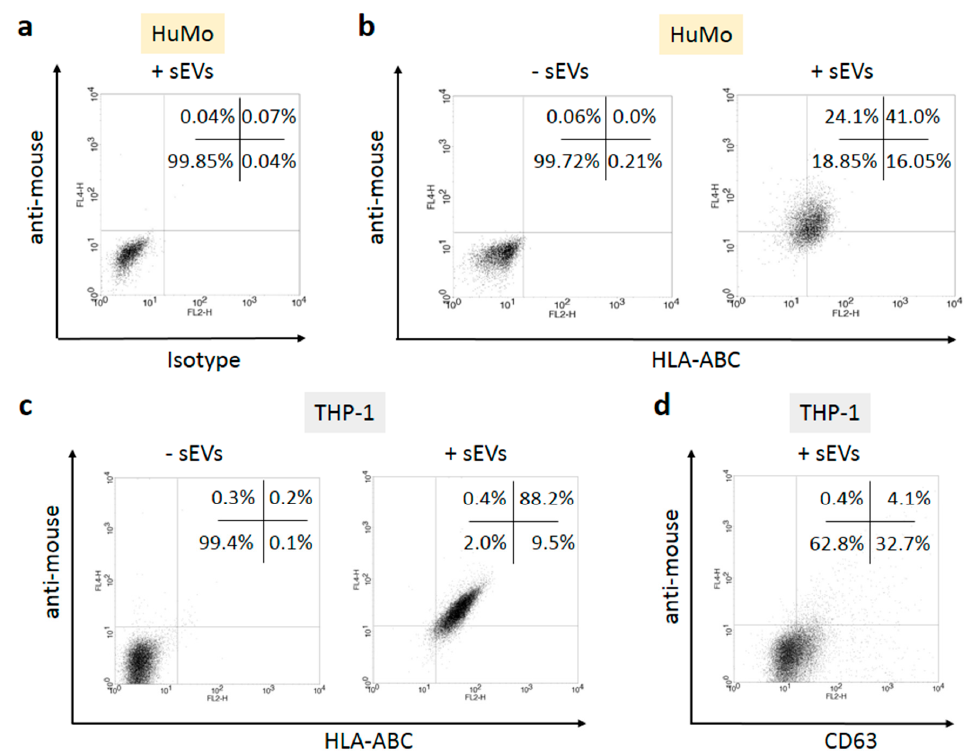
Figure 2. Melanoma cell-derived sEVs transfer MHC class I and class II molecules to the surface of APCs. The sEVs from A375 cells were incubated with PE-labelled isotype ( a ) or anti-HLA-ABC antibodies ( b , c ), purified by centrifugation, and incubated overnight with healthy donor monocytes (HuMo; a , b ) or THP-1 cells ( c , d ). The next day, the cells were stained with APC-labelled secondary anti-mouse antibodies to demonstrate the appearance of the transferred MHC/antibody complexes on the surface of the recipient cells. A negative control following the same procedure but lacking sEVs is shown in the left part of ( b ) and ( c ). ( d ) Transfer of PE-labelled anti-CD63 antibodies through sEVs, followed by staining with anti-mouse antibodies. The percentages of events in the four quadrants are indicated. The results of one representative experiment out of three are shown.